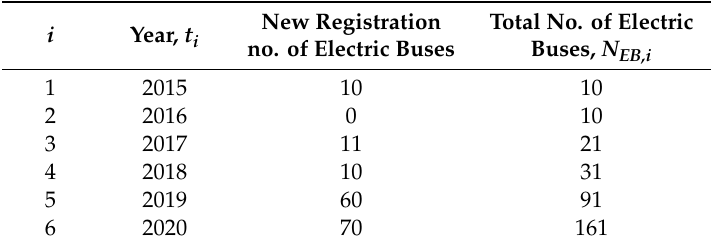
Figure 1. Forecast of the number of electric buses in Warsaw, based on [16,18]. Table 1. Input data for forecast execution [16,18].